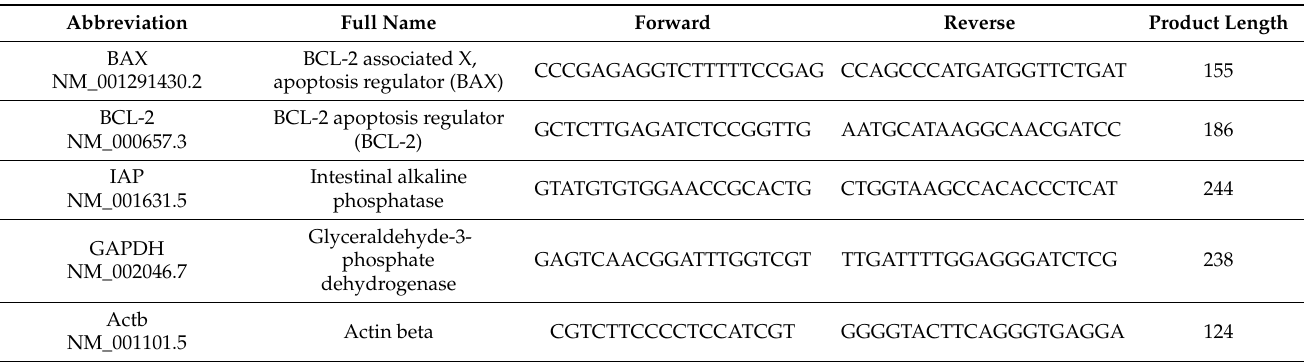
Table 2. qPCR forward and reverse primer sequences and product lengths.